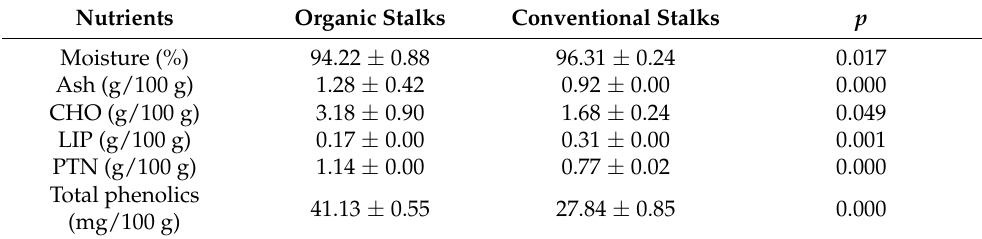
Table 2. Nutritional composition of organic and conventional stalks. Nutrients Organic Stalks Conventional Stalks p Moisture